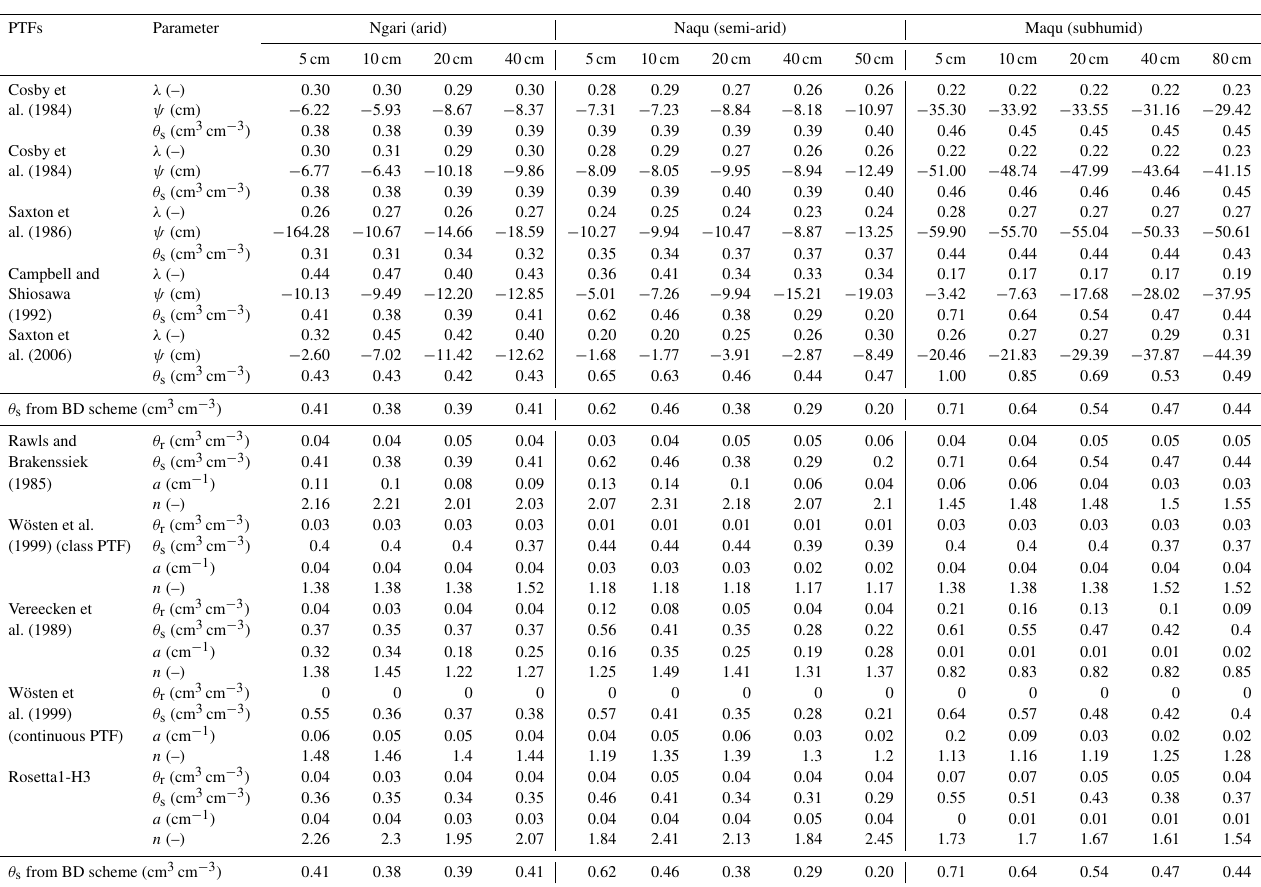
Table A3. Estimated parameters of the CH model by using PTFs over the three climate zones of the TP. It should be noted that θ s values aligned with each PTFs were estimated by their own original porosity estimate. θ s is calculated from in situ BD measurement. PTFs Parameter Ngari (arid)